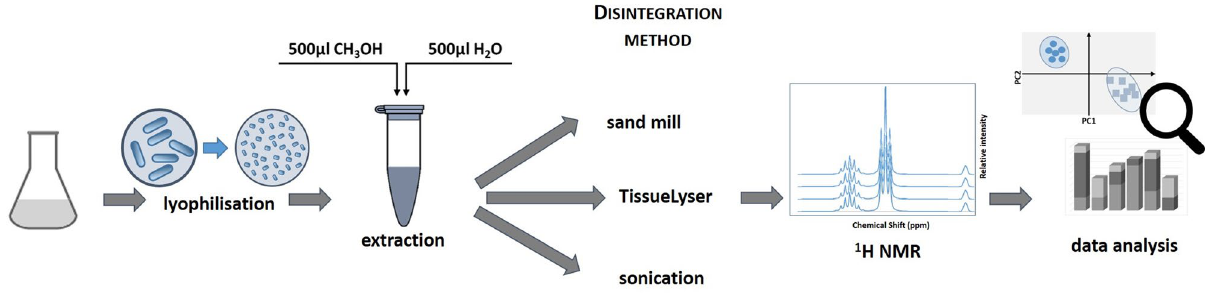
Figure 1. The experiment